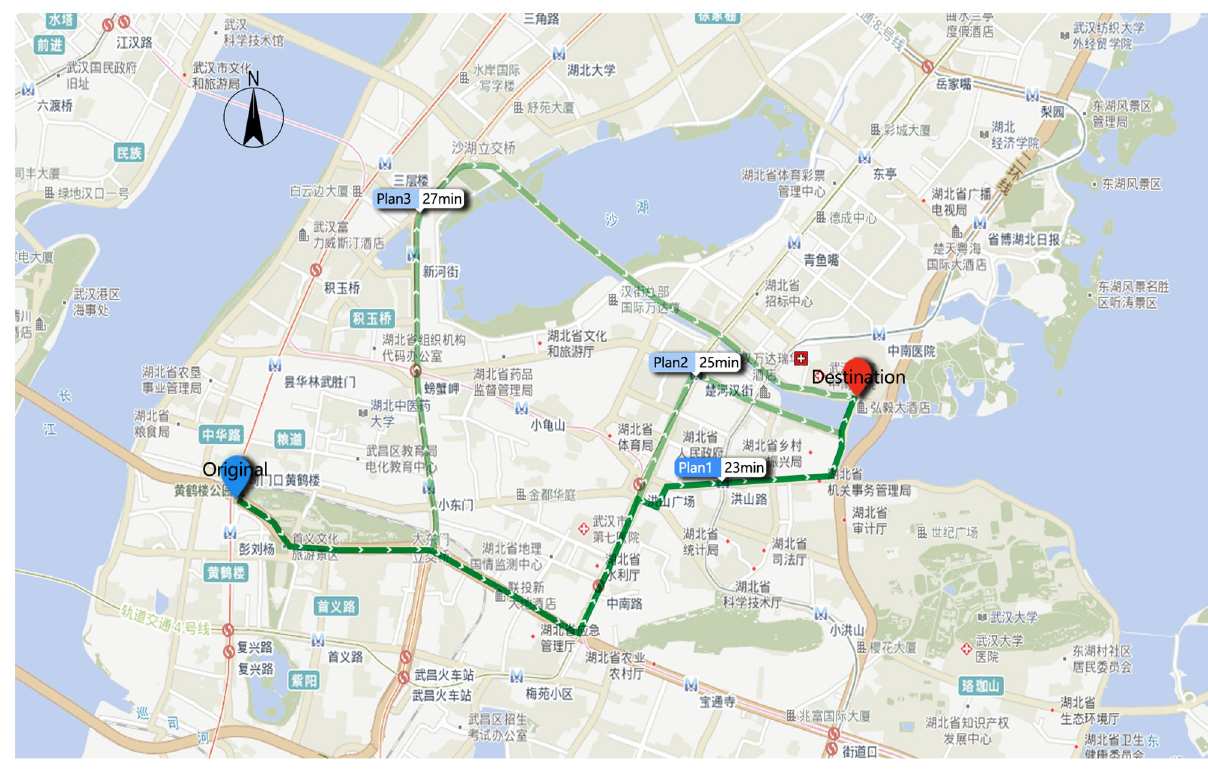
Fig 5. Navigation diagram of selected origin–destination (OD) routes.